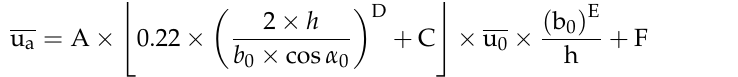
Figure 10. Full set of test results for visual aerodynamic sealing of the air curtain (nozzle thickness). The pictures show that: The average door velocity value increases with the jet thickness.